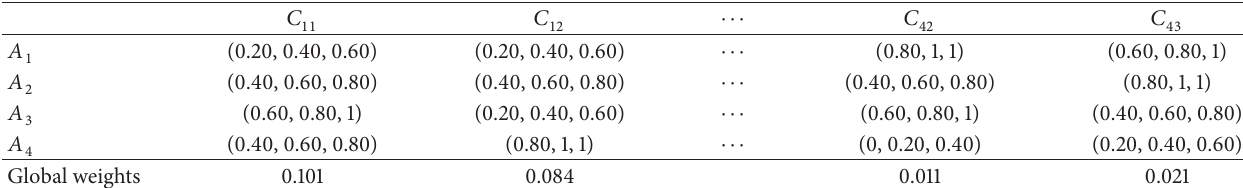
Table 7: Initial FTOPSIS decision matrix for four alternative companies.